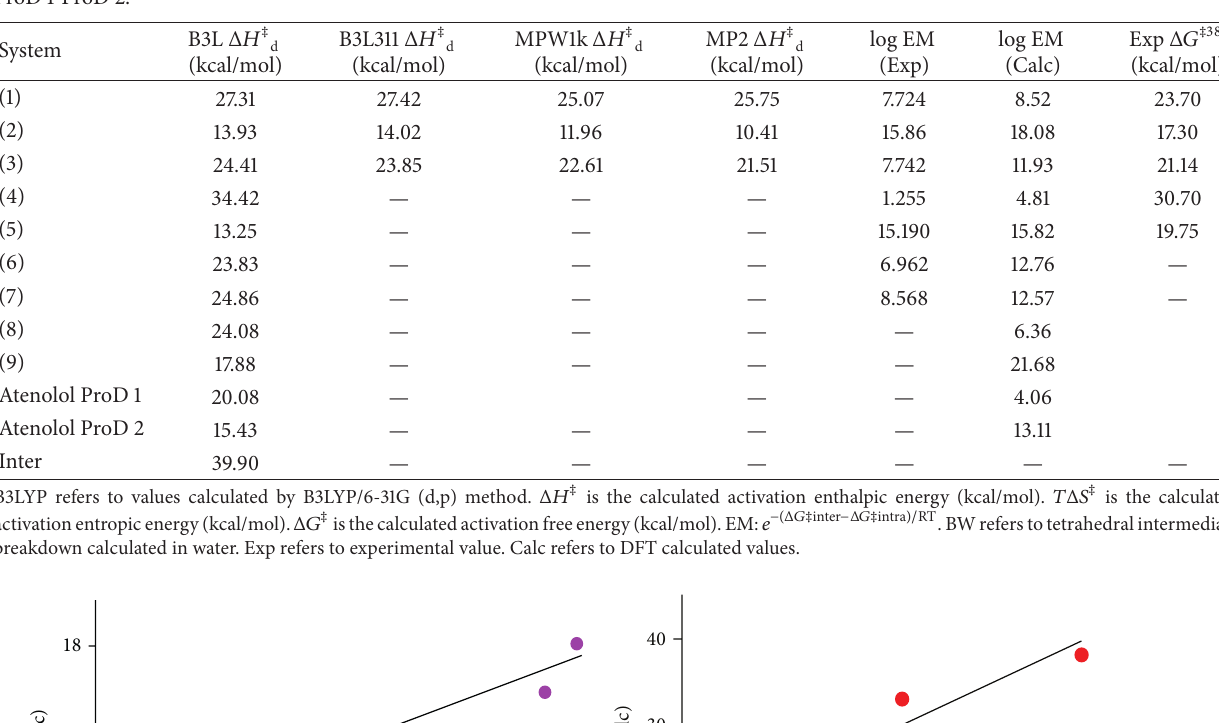
Table 1: Experimental and DFT calculated kinetic and thermodynamic properties for the acid-catalyzed hydrolysis of 1–9, Inter, and atenolol ProD 1-ProD 2.